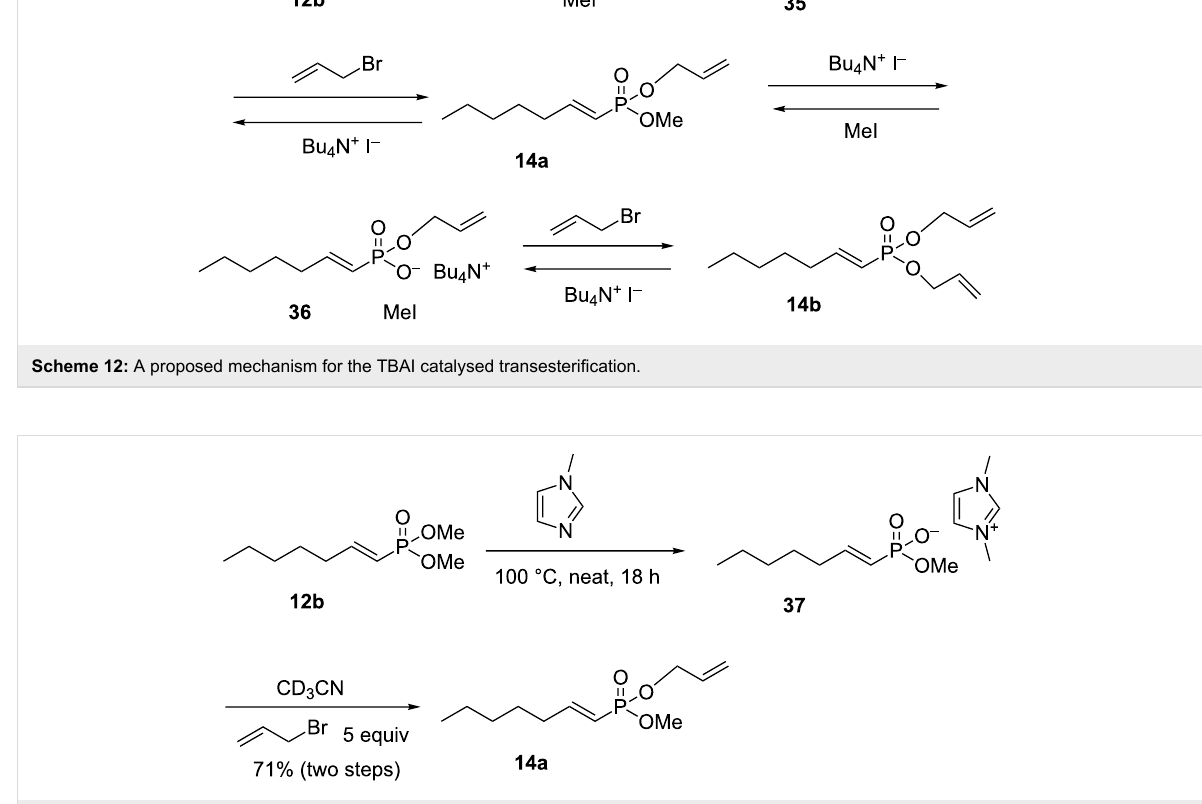
Scheme 13: A selective synthesis of mono-allyl phosphonates.